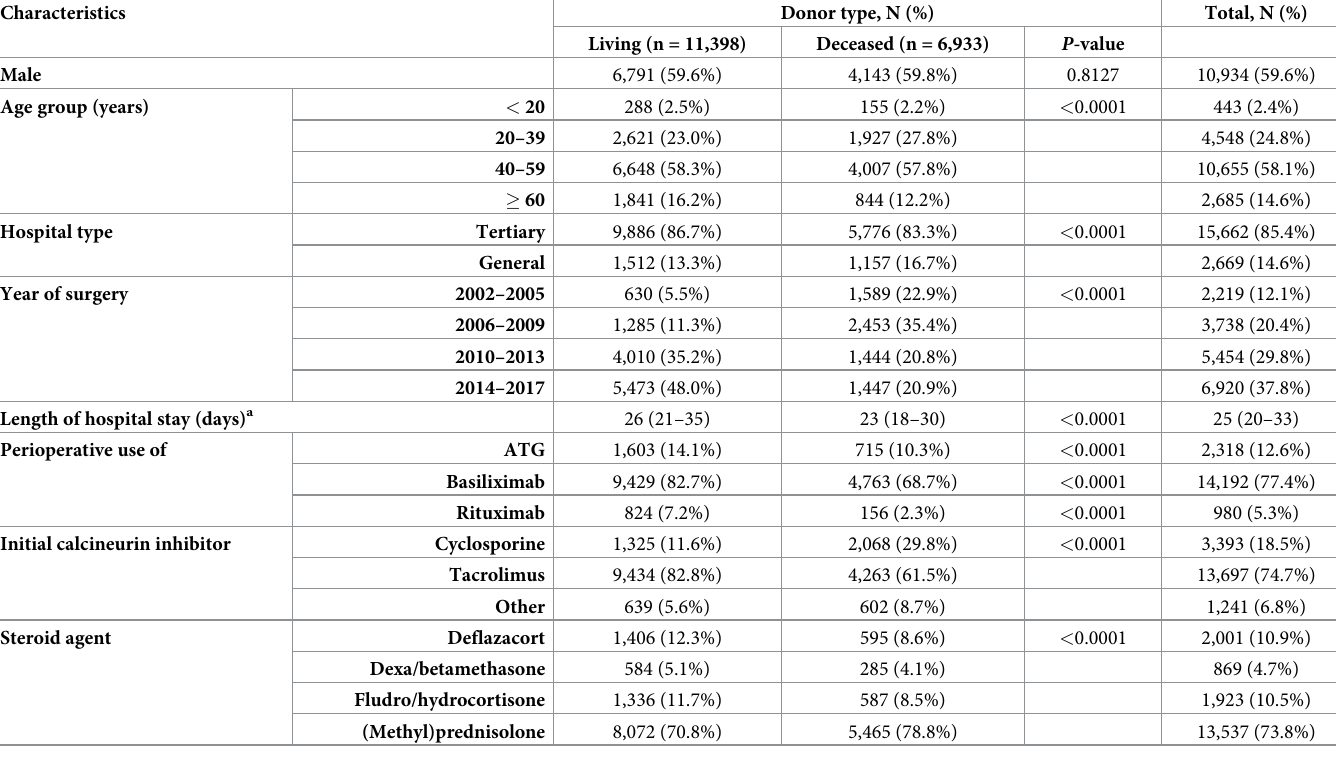
Table 1. Characteristics of patients (n =